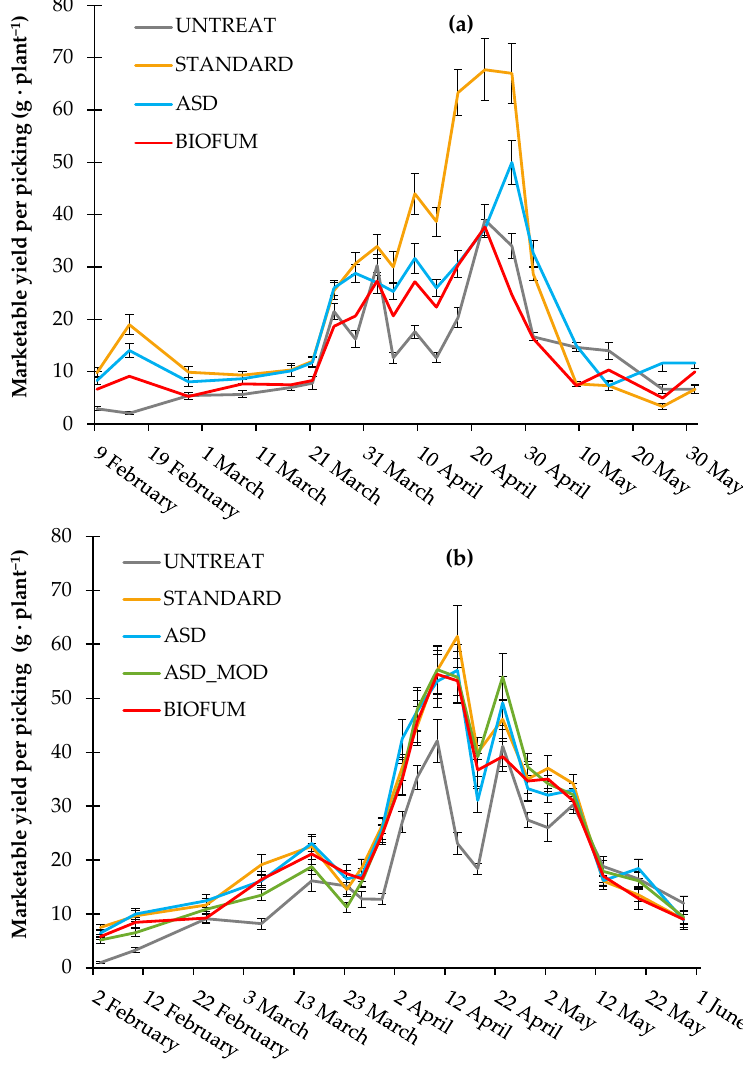
Figure 5. Patterns of the harvest seasons 2018/2019 (( a ) above, adapted from [42]) and 2019/2020 (( b ) below) of Sabrosa* under different soil pre-planting treatments. Average yield plant − 1 ± standard error. Yield data in the two cropping seasons are reported in Table 2. While in the STAN- DARD plots the yield performance was similar in the two years, the yield plant − 1 of